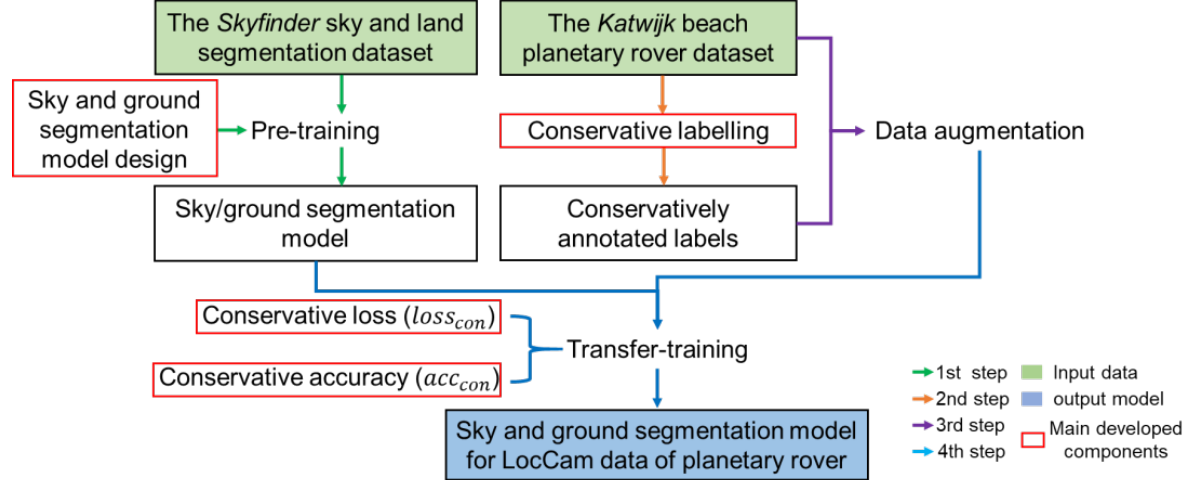
Figure 2. The overall process of the proposed framework. The red frames refer to the main innovations in this research. Green and blue frames refer to the inputs and outputs of the framework. LocCam refers to the localization camera of the planetary rovers.